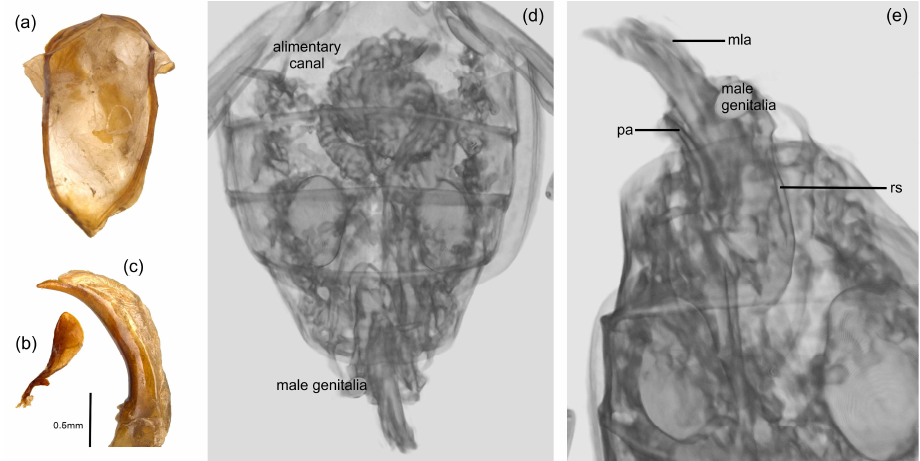
Figure 6. Genitalia of P. teriolensis . Male: ( a ) ring sclerite, rs; ( b ) paramere, pa; ( c ) The median lobe of the aedeagus is, mla; ( d ) microCT image of male abdomen; ( e ) microCT image, including detail of the distal part of abdomen in male, with the genitalia partly exposed, and the reciprocal position of the parts marked.